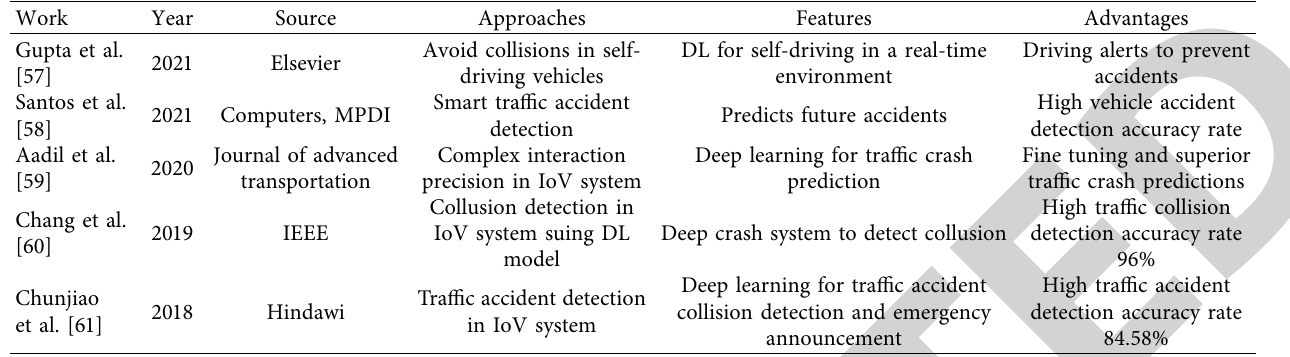
Table 3: Summary of deep learning applications for IoV collision